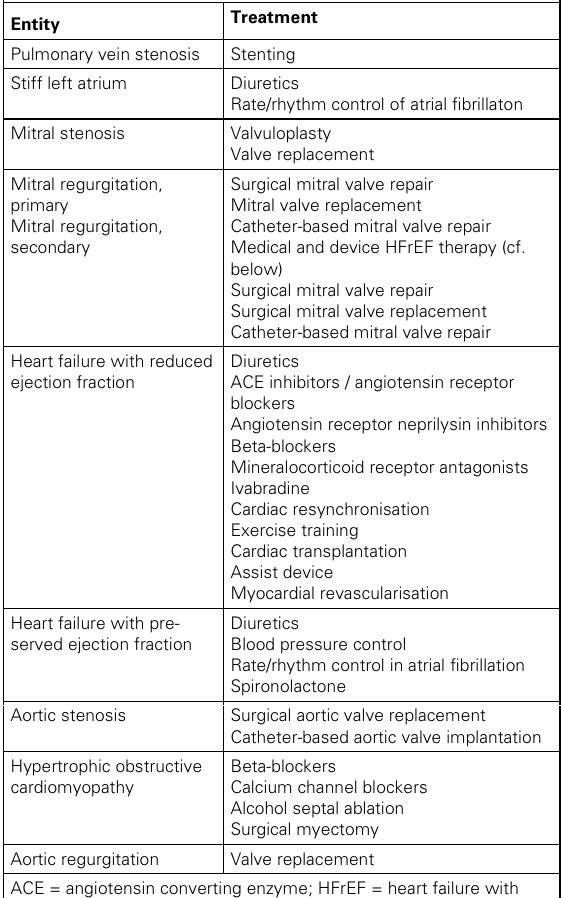
Table 5: Treatment of different entities of pulmonary hypertension associated with left-sided heart